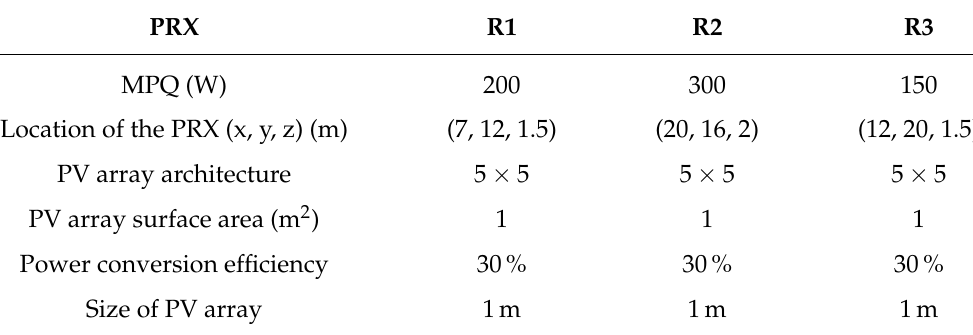
Table 5. Characteristics of the PRXs used in the